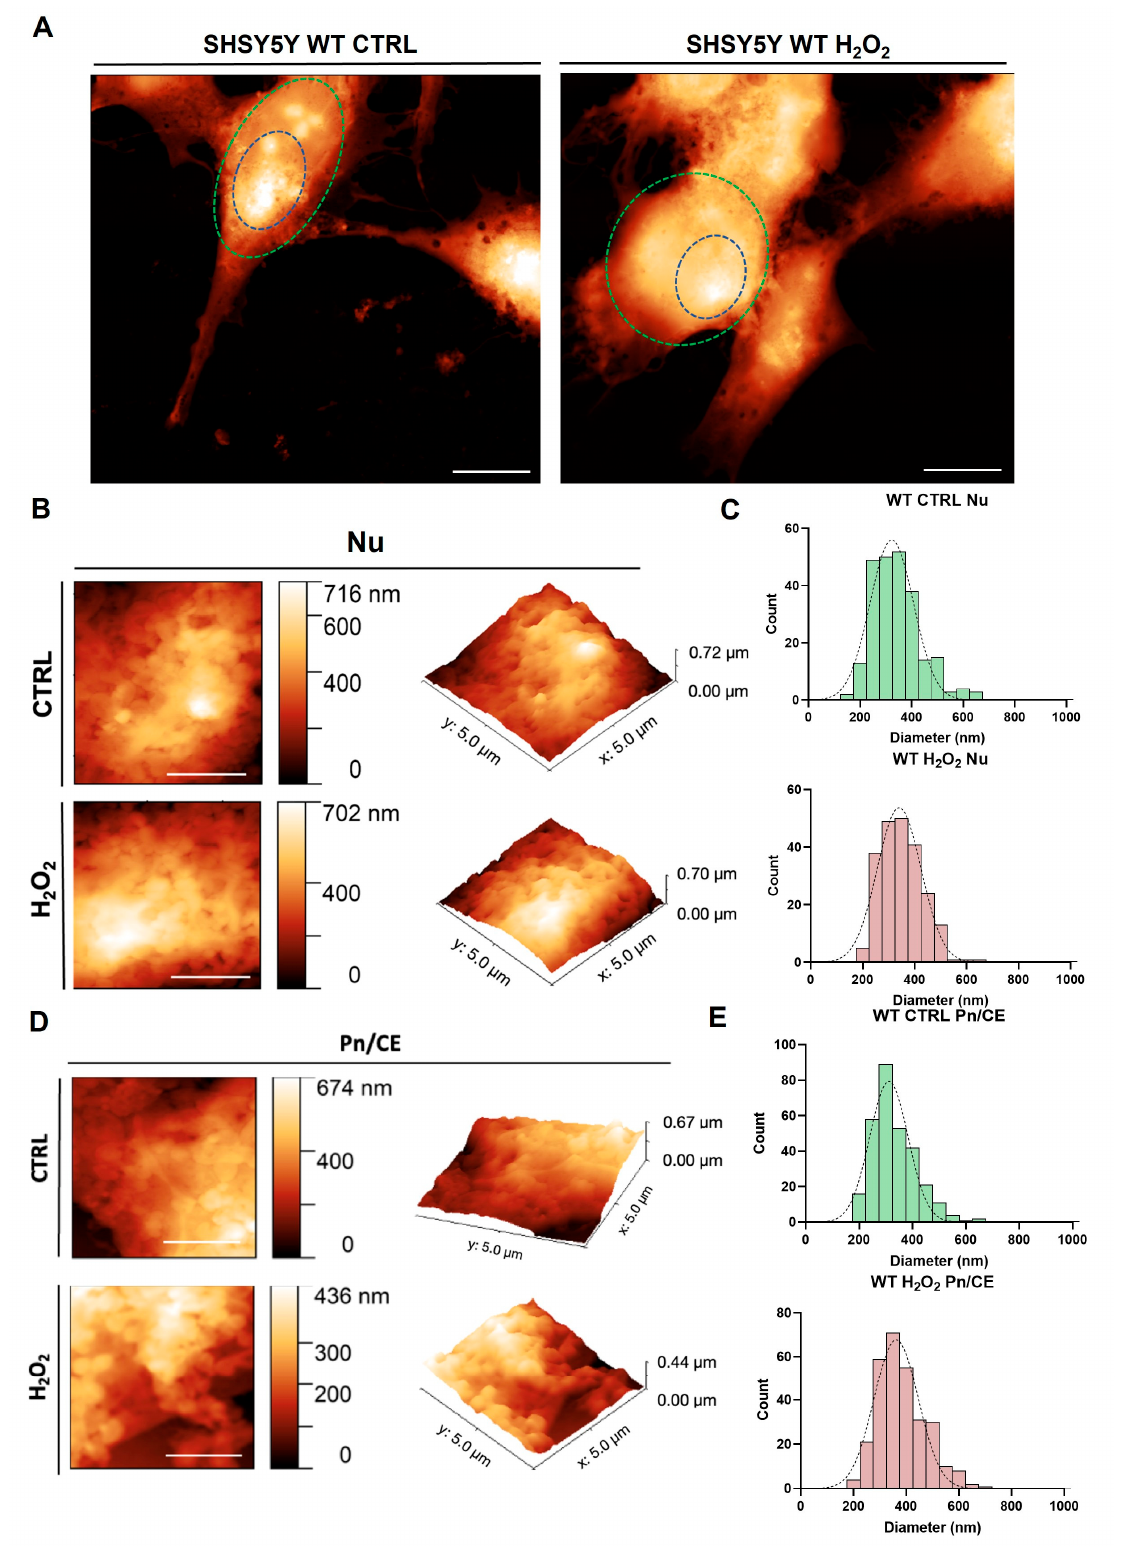
Figure 4. Mapping of the surface of CTRL ( A ) and H 2 O 2 ( B ) WT SH-SY5Y cells in the nuclear zone ( B ) and perinuclear-to-cellular edge regions ( D ), with relative 3D reconstructions and size dis- tributions ( C , E ), Ntot = 243, 273, 298, and 292. Scale bars = 10 µ m for whole cells micrographs; 1 µ m for magnifications of the 3 × 3 µ m 2 mapped regions. Nu = nuclear zone (blue circles); Pn/CE = perinuclear-to-cellular-edge regions (green